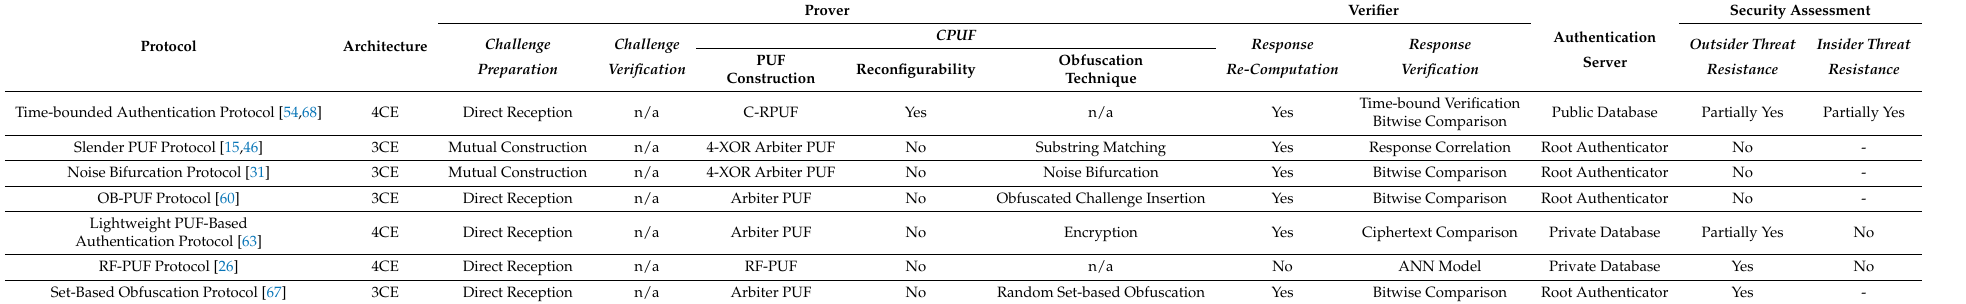
Table 1. Summary of the studied enrollment